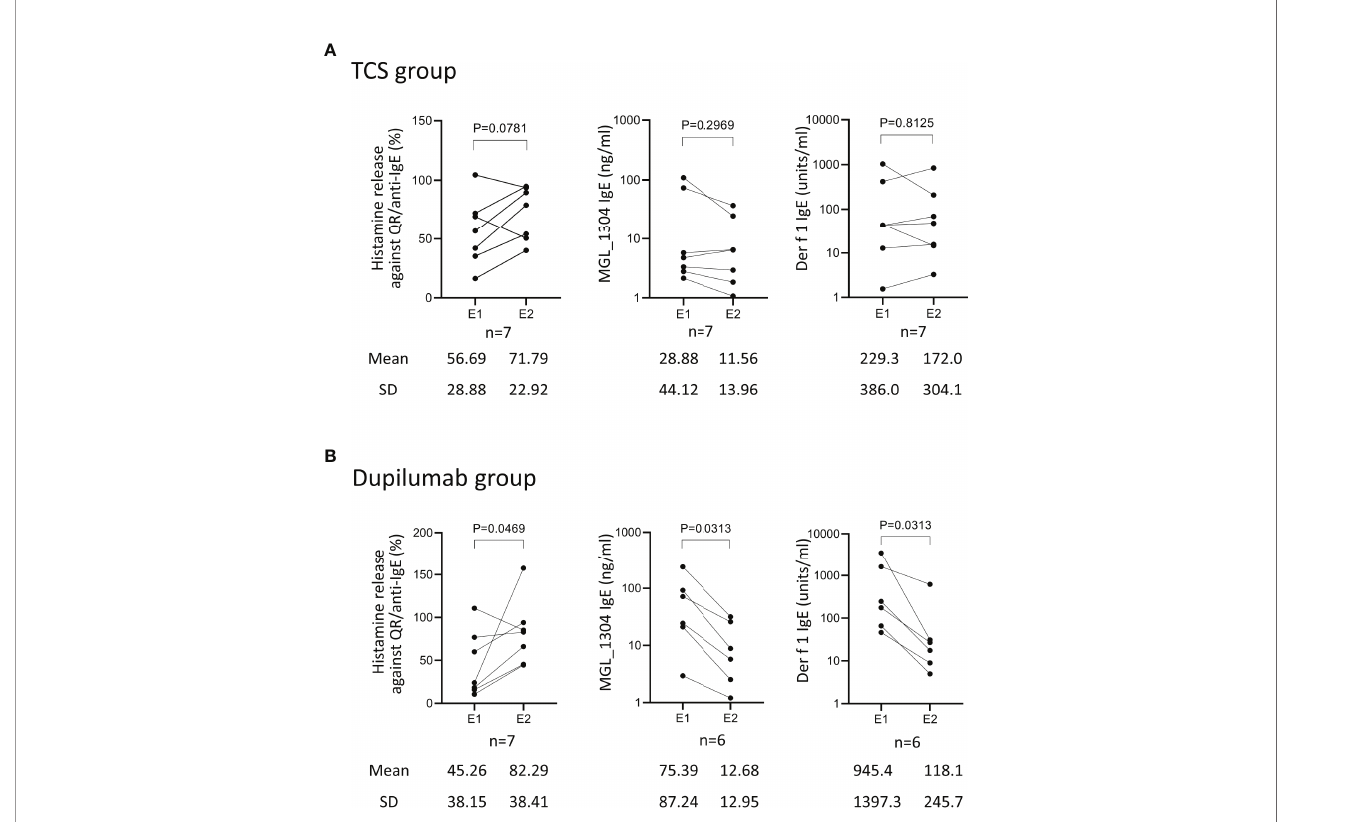
FIGURE 2 | Histamine release from basophils in response to QR, and levels of IgE against MGL_1304 and Der f 1 at E1 and E2 in patients treated with TCS (TCS group) (A) and those treated with TCS plus dupilumab (dupilumab group) (B) . TCS, topical corticosteroid. Histamine release was expressed as (net % of histamine release induced by QR)/(net % of histamine release induced by anti-human IgE)×100 (%). E1, the 1st evaluation; E2, the 2nd